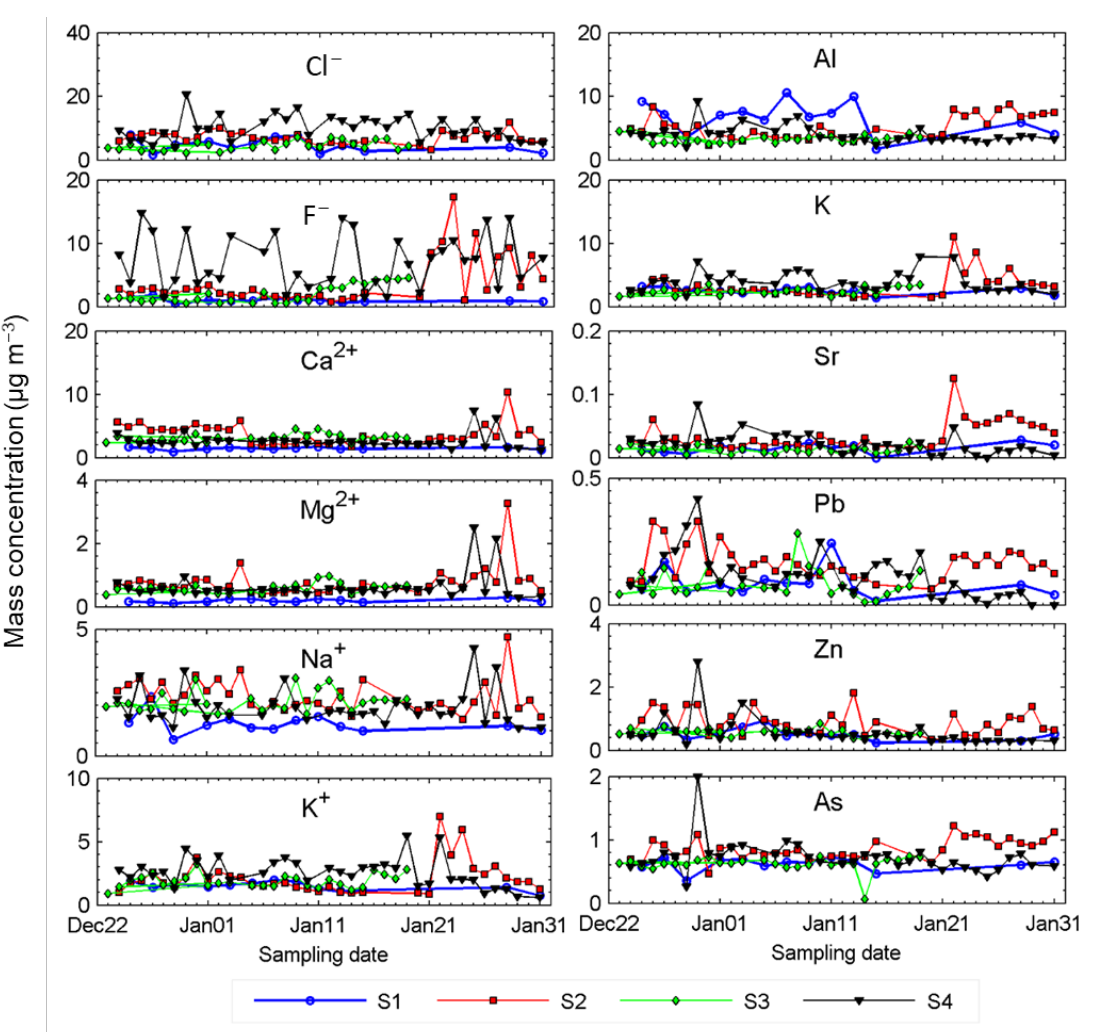
Figure 5. Temporal variations of mass concentrations of the representative ions and elements in the daily PM 2.5 samples.